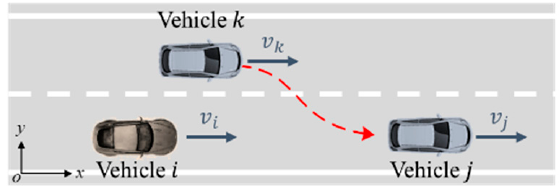
Figure 8. Car-following experimental scenario. Figure 9. Cut-in experimental scenario.